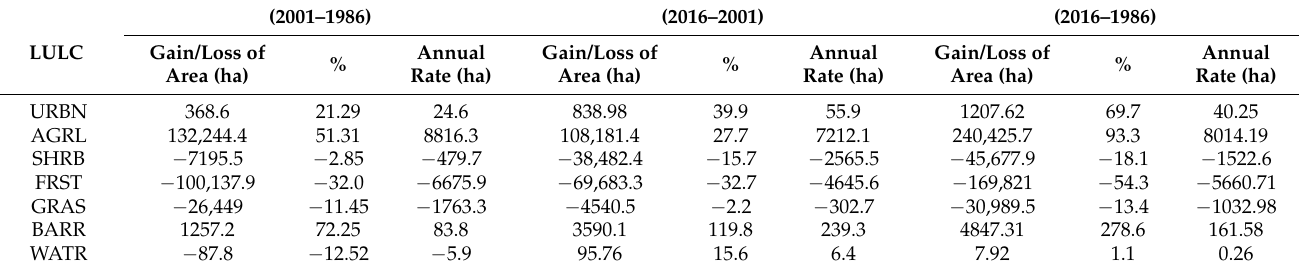
Table 3. LULC conversion between the study years and corresponding annual rates.